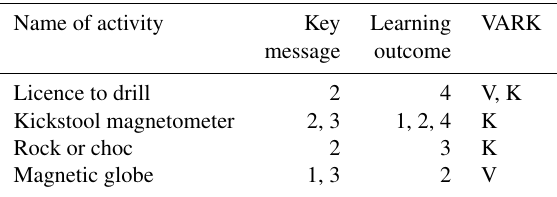
Table 2. Overview of the relation between hands-on activities, key messages, learning outcomes, and learning preferences. Note: VARK – visual, aural, read/write, kinesthetic. Name of activity